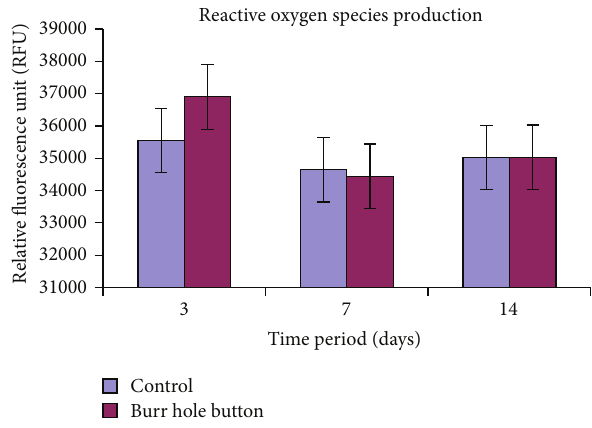
Figure 5: Measurement of the level of reactive oxygen species. All values are expressed as mean ± Std. deviation from three different